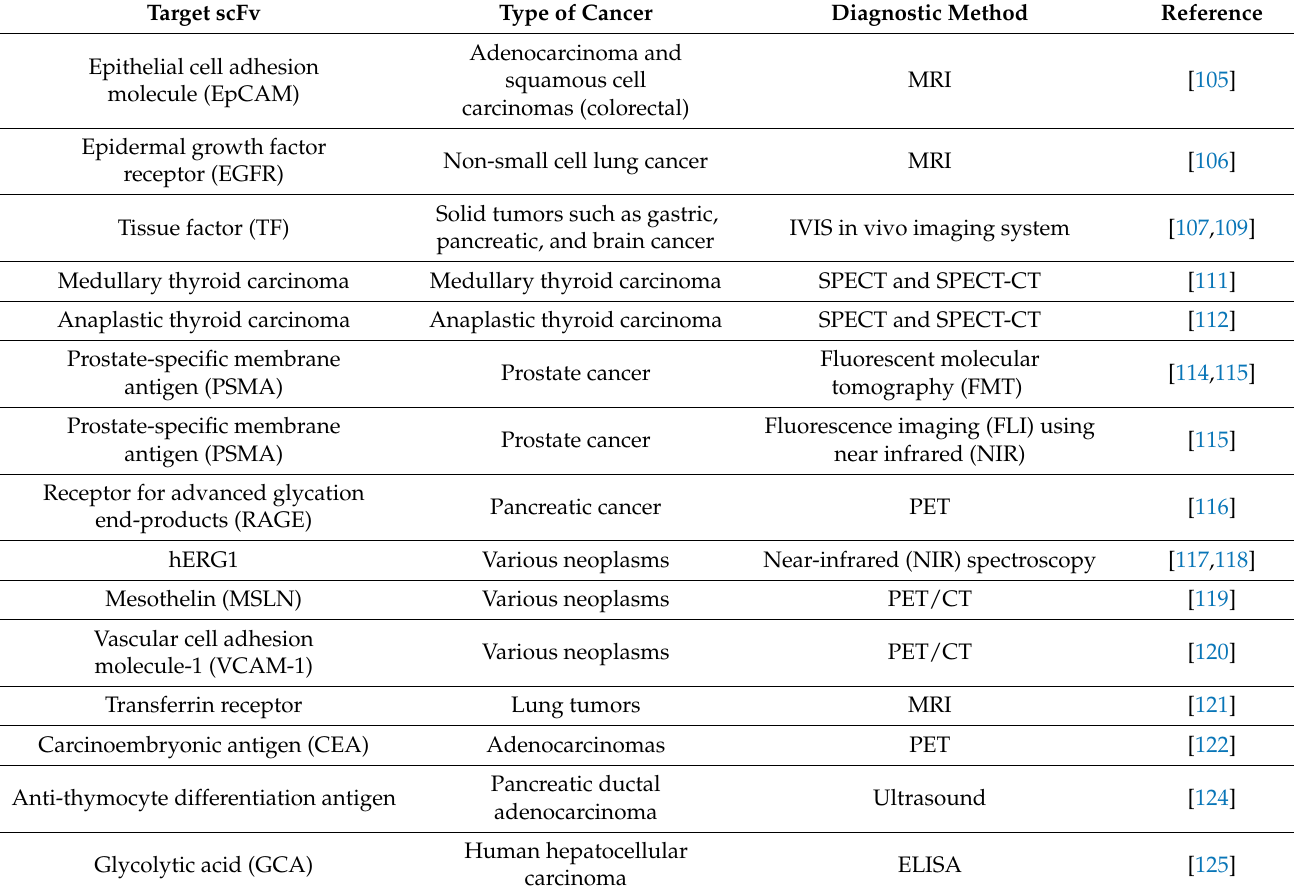
Table 1. scFv as a diagnostic tool in